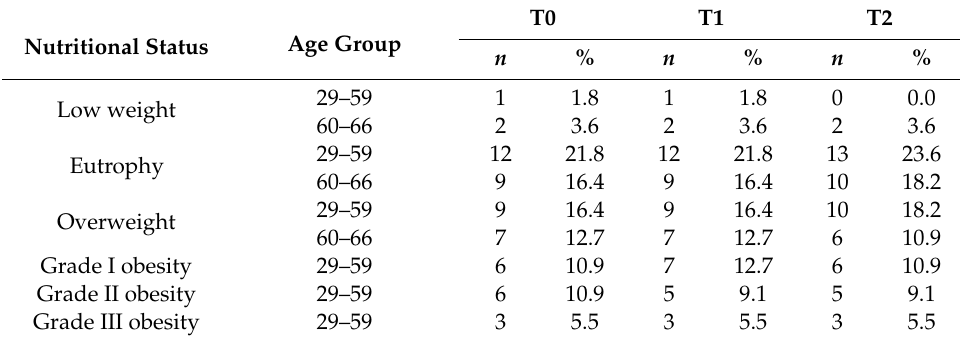
Table 2. Nutritional status of women with breast cancer on chemotherapy at a university hospital in Uberl â ndia, MG, Brazil, 2014–2015 ( n =